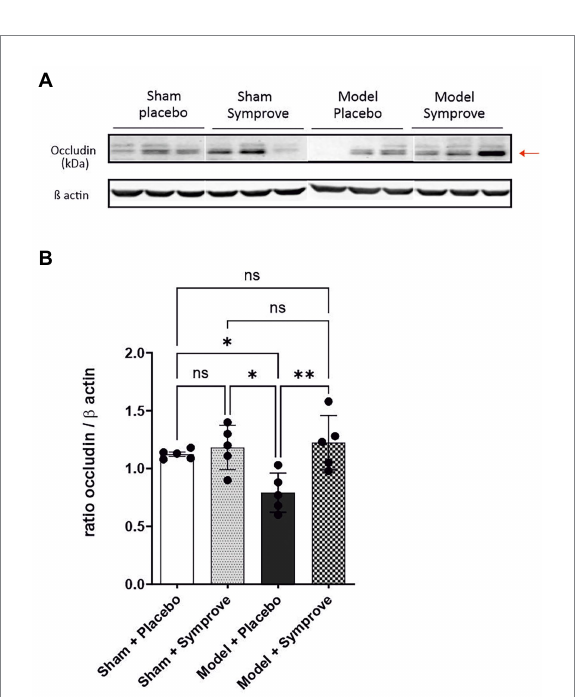
FIGURE 3 Effect of Symprove ™ on gut integrity in the early-stage PD rat model. (A) Western blot analysis of occludin levels in the four experimental groups ( n = 3 per group displayed): Sham + placebo, Sham + Symprove ™ , model + placebo and model + Symprove ™ . (B) Plots representing occluding/ β actin ratio for the four experimental groups ( n = 5 per experimental group). Data are displayed as mean ± SEM. [ANOVA; ns Not significant, * p < 0.05, ** p < 0.01]. The occludin/ β actin ratio was decreased in the ESPD model compared with sham animals treated with placebo or Symprove ™ . This decrease was prevented by treatment with Symprove ™